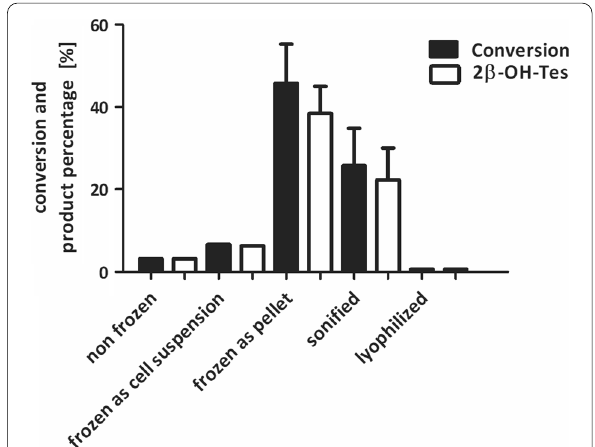
Fig. 3 Effect of different handling of resting cells of E. coli C43 (DE3) pET22b- cyp105D pCOLADuet- pdx - pdr on testosterone 1 + conversion and formation of 2β-hydroxytestosterone 2 (2β-OH-Tes). Reaction conditions: 50 mg/mL wet cells in 0.5 mL Phosphate Sucrose EDTA (PSE)- buffer with 1 x nutrient solution, pH 7.5 in 2 mL reaction tubes; 1 mM testosterone 1 dissolved in 5% (v/v) propan-2-ol as final concentration, 25 °C, 1100 min − 1 shaking frequency,